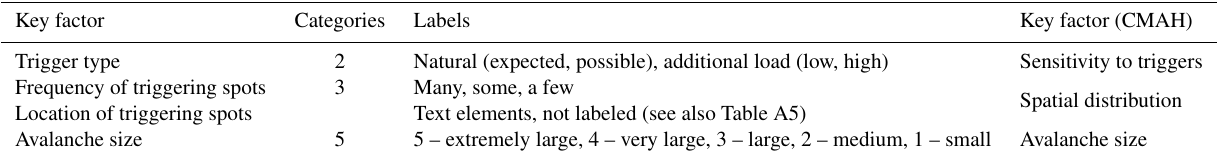
Table 4. Labels and number of categories used to describe the key factors. In addition to the labels shown, a value could also be labeled not assignable . The order of the labels corresponds to the rank order used in this analysis with the left-most labels representing the most unfavorable conditions and the right-most label the most favorable conditions. A comparison with the terms used in the conceptual model of avalanche hazard (CMAH) is also provided as a